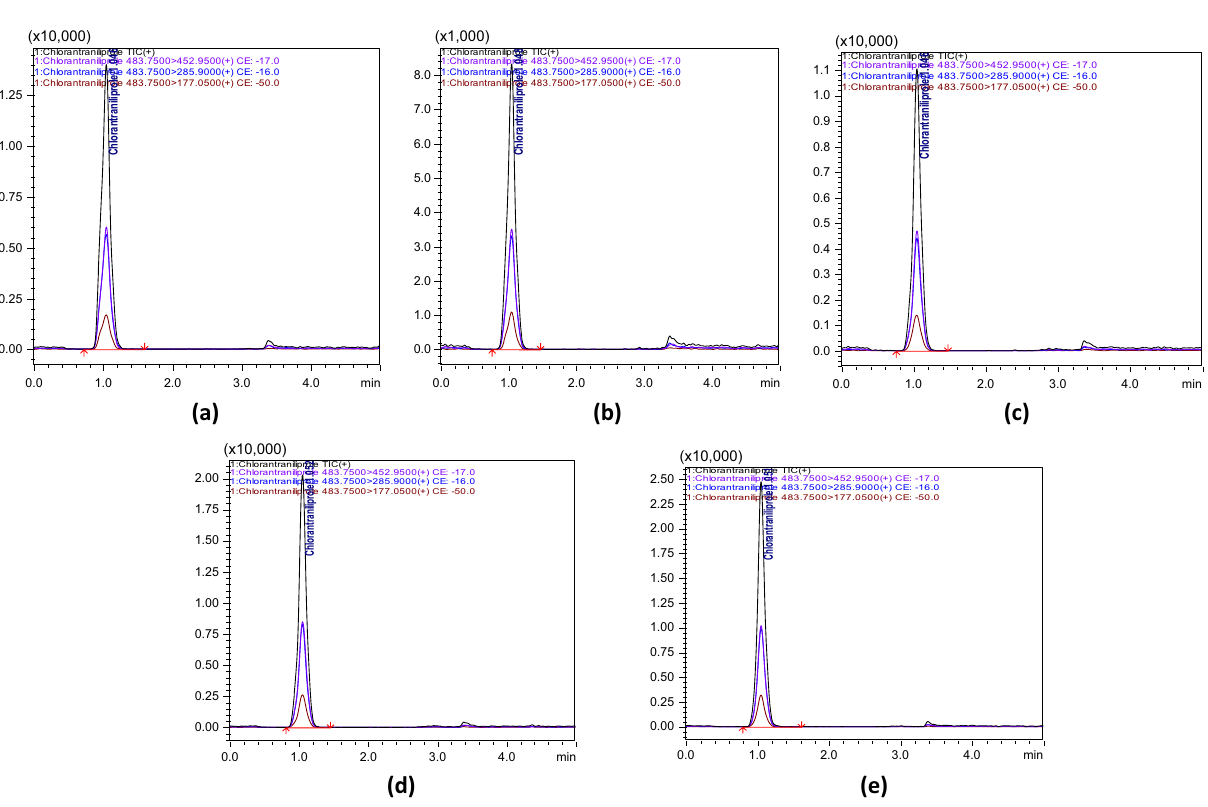
Figure 3. Recovery chromatogram of ( a ) husk at 0.01 µg g −1 ( b ) paddy leaf at 0.01 µg g −1 ( c ) paddy straw